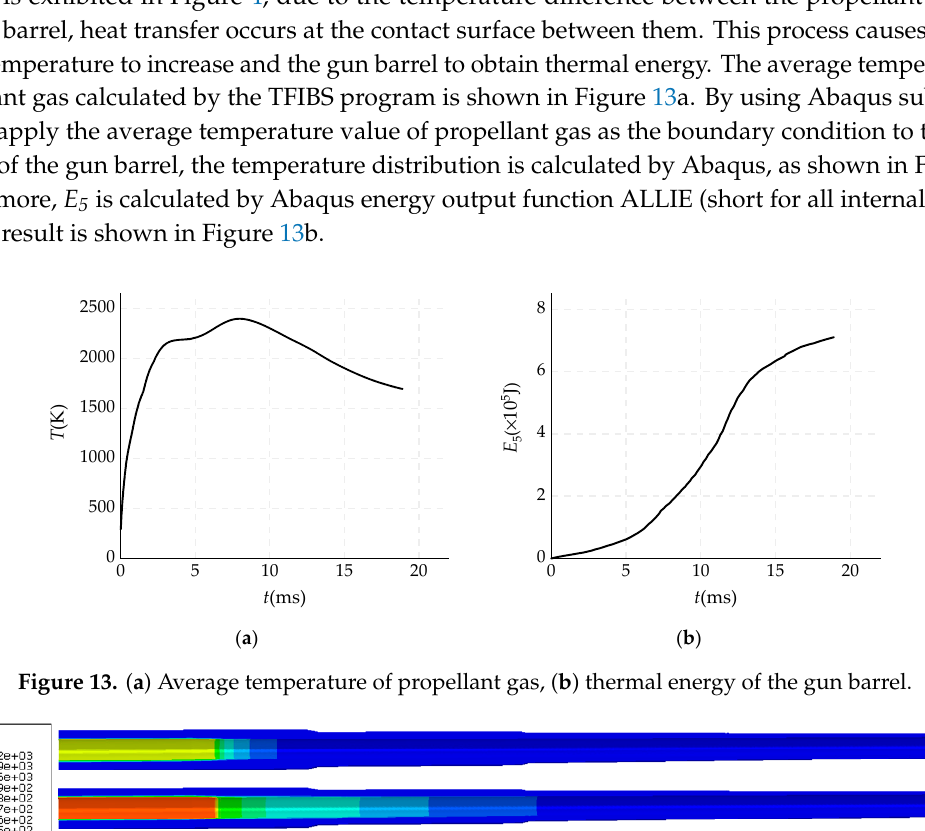
Figure 12. ( a ) Pressure at breech and gun barrel displacement, and ( b ) recoil energy.